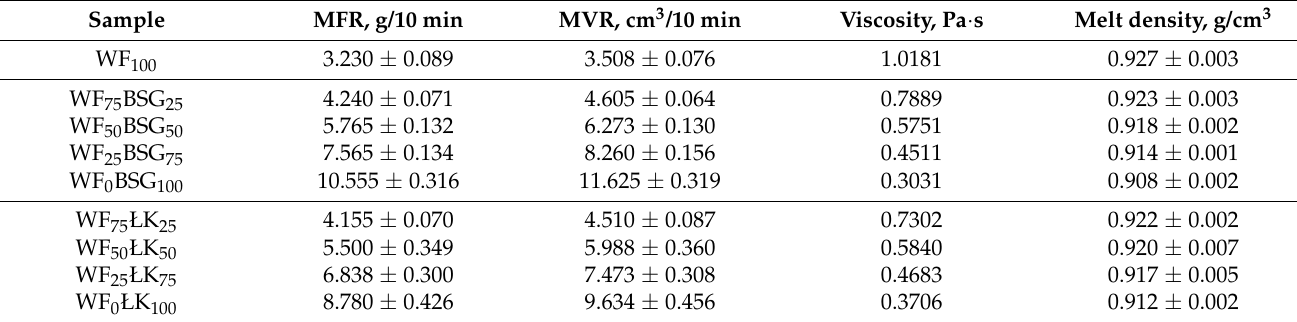
Table 3. Results of the melt flow analysis of prepared composites.